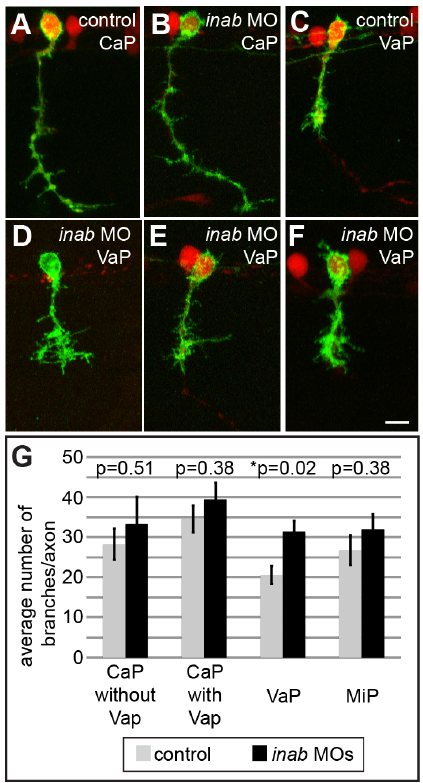
Figure 5. inab is required for morphology of VaP axons. ( A–F ) Z- projections of confocal images of control and inab MO-injected embryos. At 26 hpf, UAS:EGFP plasmid injection into mnx1:GAL4;UAS:td- Tomato transgenic embryos reveals similar overall morphology of CaP neurons in both control (A) and MO-injected embryos (B). VaP axons in MO-injected embryos (D–F) have more processes than VaP axons in control embryos (C). ( G ) Graph representing average number of branch points per axon in individually-labeled cells in control and MO-injected embryos. No significant difference between conditions for CaP neurons alone (n=11, p=0.51), CaP MNs that are located next to VaP MNs (n=11, p=0.38), or MiP MNs (n=10, p=0.38). Only the increase in VaP axon processes is significant (n=14, p=0.02). Scale bar is 10 m m in